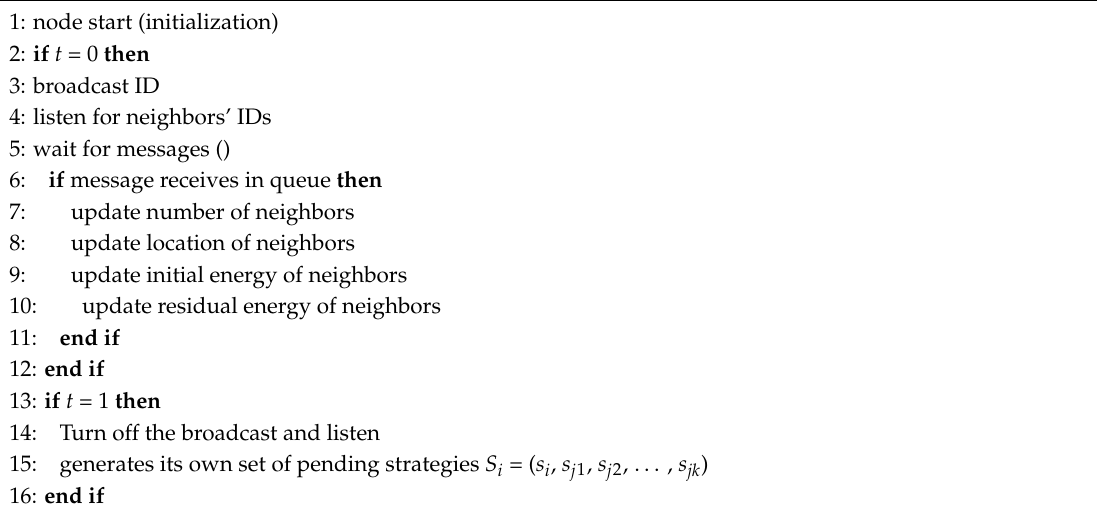
Algorithm 1. DCGA for every node in the network in neighbor discovery